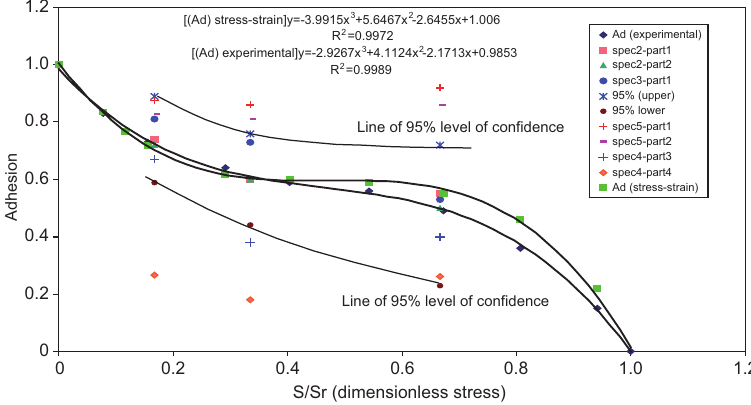
Figure 4 Plot of the adhesion curves vs. dimensionless stress